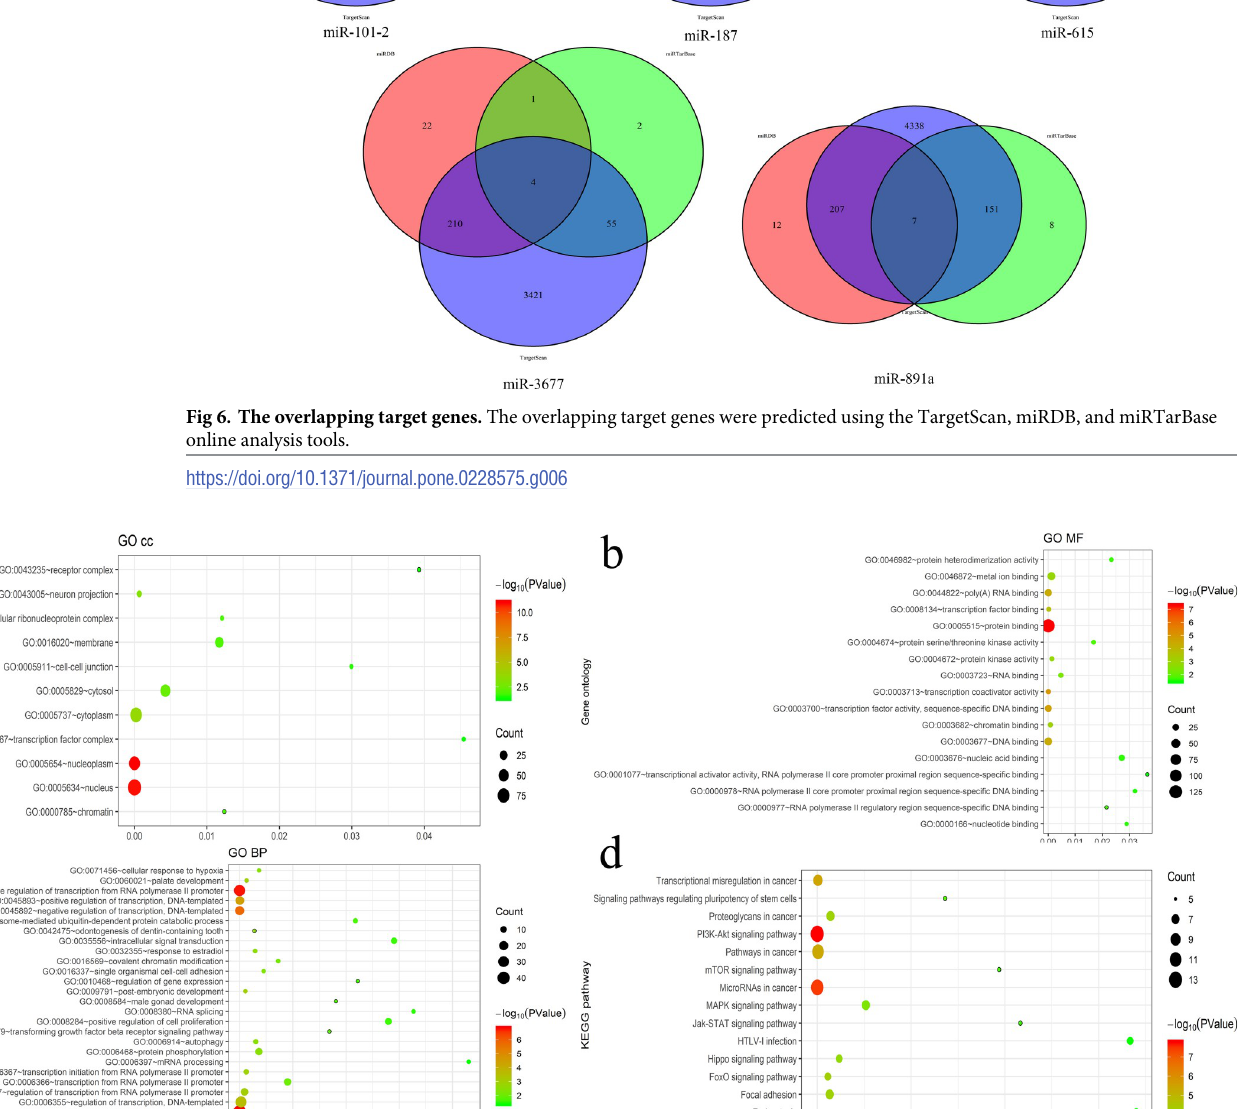
PLOS ONE | https://doi.org/10.1371/journal.pone.0228575 February 12,